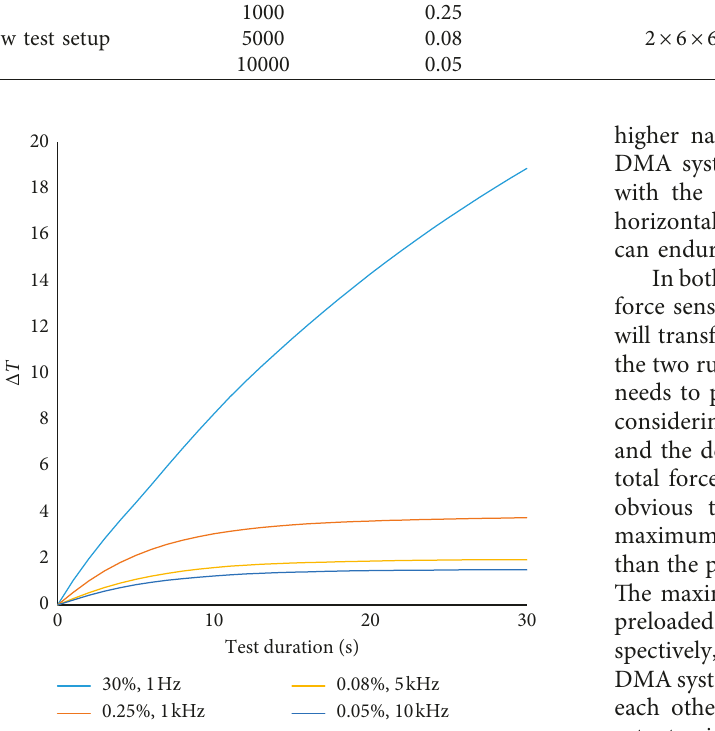
Figure 7: The increase of the maximum temperature of the rubber specimen due to the heat build-up during the